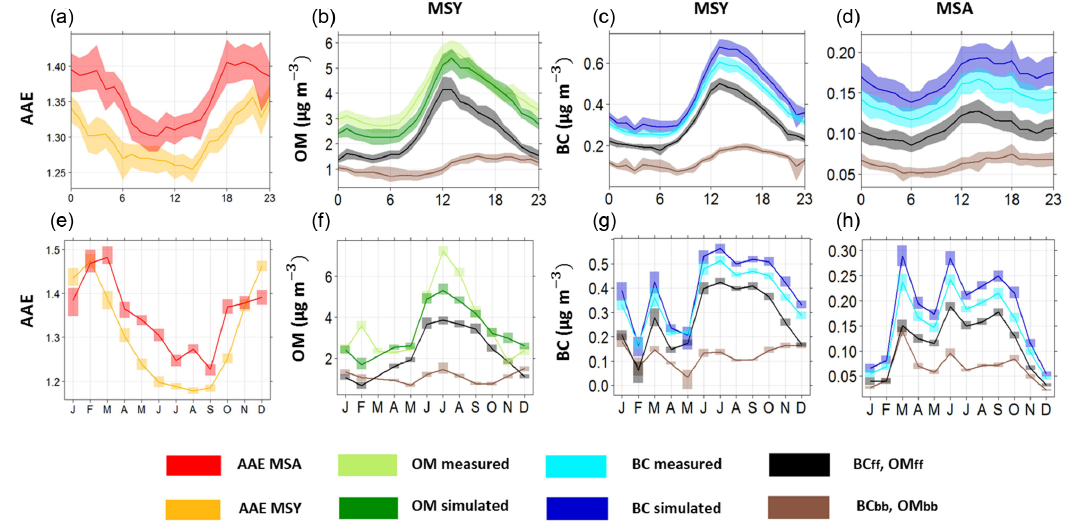
Figure 6. Daily cycle of (a) AAE at MSY and MSA, (b) measured OM and simulated OM as the sum of OM ff and OM bb contributions at MSY, measured BC and simulated BC as the sum of BC ff and BC bb contributions at (c) MSY and (d) MSA. Annual cycle of (e) AAE at MSY and MSA, (f) measured OM and simulated OM as the sum of OM ff and OM bb contributions at MSY, measured BC and simulated BC as the sum of BC ff and BC bb contributions at (g) MSY and (h) MSA. The study period ranges between 14 June 2012 and 9 July 2013 for OM contributions and between 12 June 2012 and 31 December 2014 for BC contributions, depending on the availability of BC and OM experimental measurements respectively. Averages were calculated on an hourly basis.